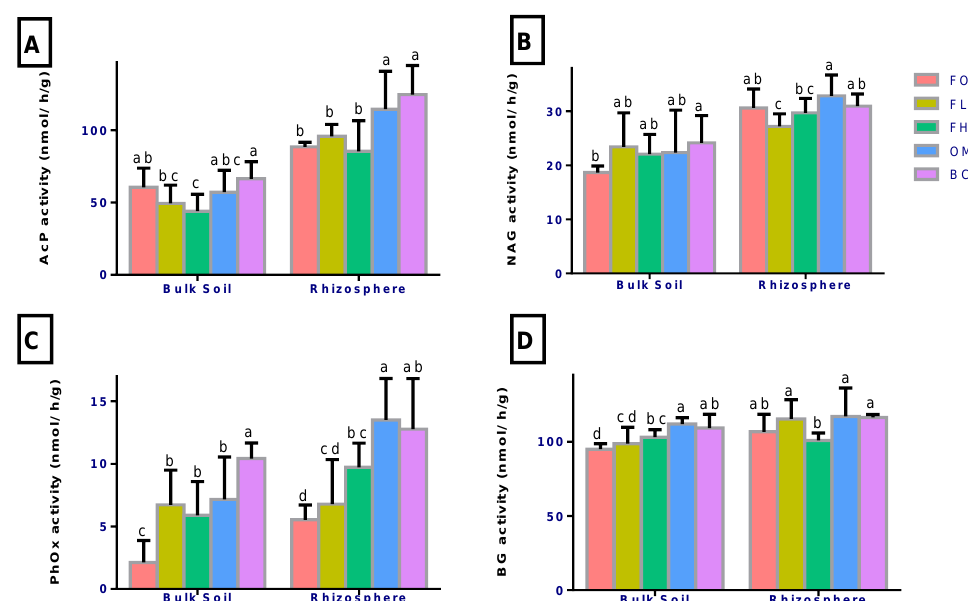
Figure 2. Soil enzyme activities across chemical fertilizer, manure, and biochar treatments in rhizosphere and bulk soils. ( A ) AcP, acid phosphatase; ( B ) NAG, β -1,4- N -acetyl-glucosaminidase; ( C ) PhOx, phenol oxidase; and ( D ) BG, β -1,4-glucosidase. Units for all enzyme activities are nmol activity h − 1 g − 1 soil. FO: no fertilizer, control; LF: low fertilizer; HF: high fertilizer, OM: manure; and BC: biochar. Values are the means of the eight replicates of each treatment. The different alphabet letters indicate that there are significant differences (ANOVA, LSD test, p < 0.05) among fertilizer treatments. The error vertical bars represent standard error bars.